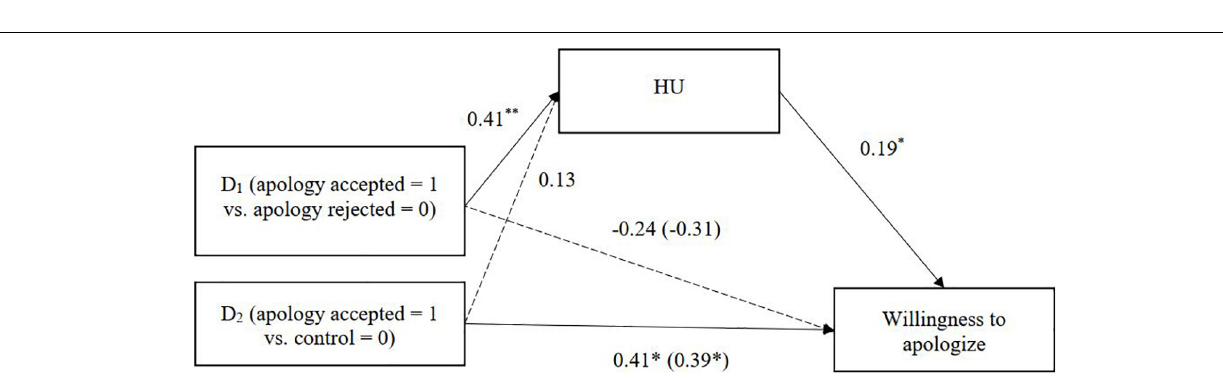
FIGURE 5 | HU mediating the relationship between perceived apology acceptance and willingness to apologize (Study 2). Unstandardized coefficients are presented. Coefficients in parentheses denote direct effects after controlling for indirect effects. ∗ p < 0.05, ∗∗ p < 0.01.